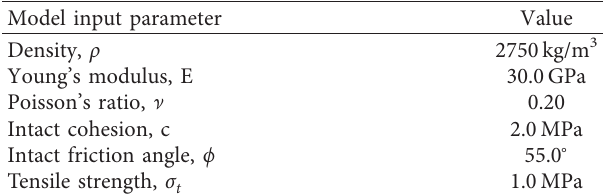
Figure 3: Tunnel geometry and layout of monitoring points in the reference section ( Z � 60 m) (unit: m). Table 1: Finite difference mesh input parameters used in the three- dimensional tunnel